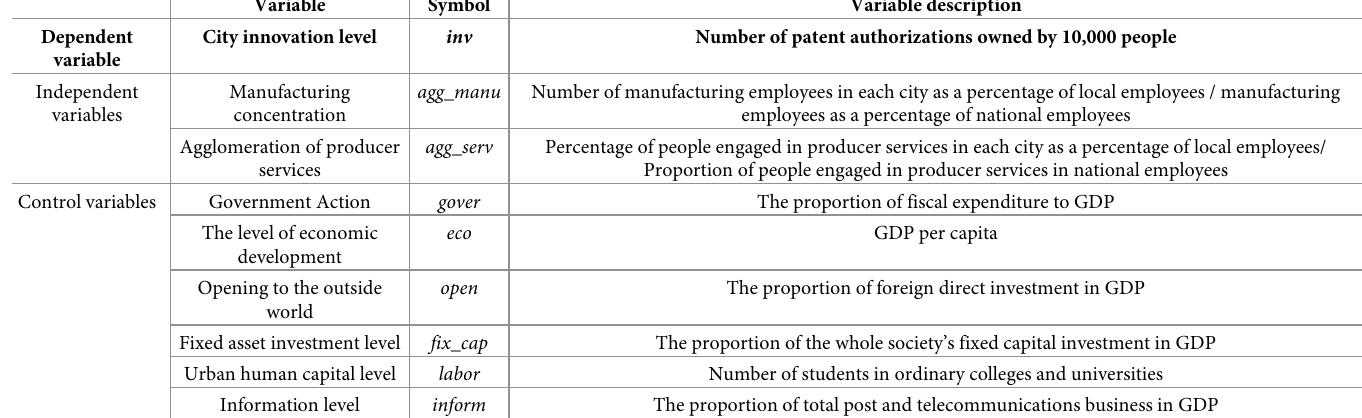
Table 1. Variable